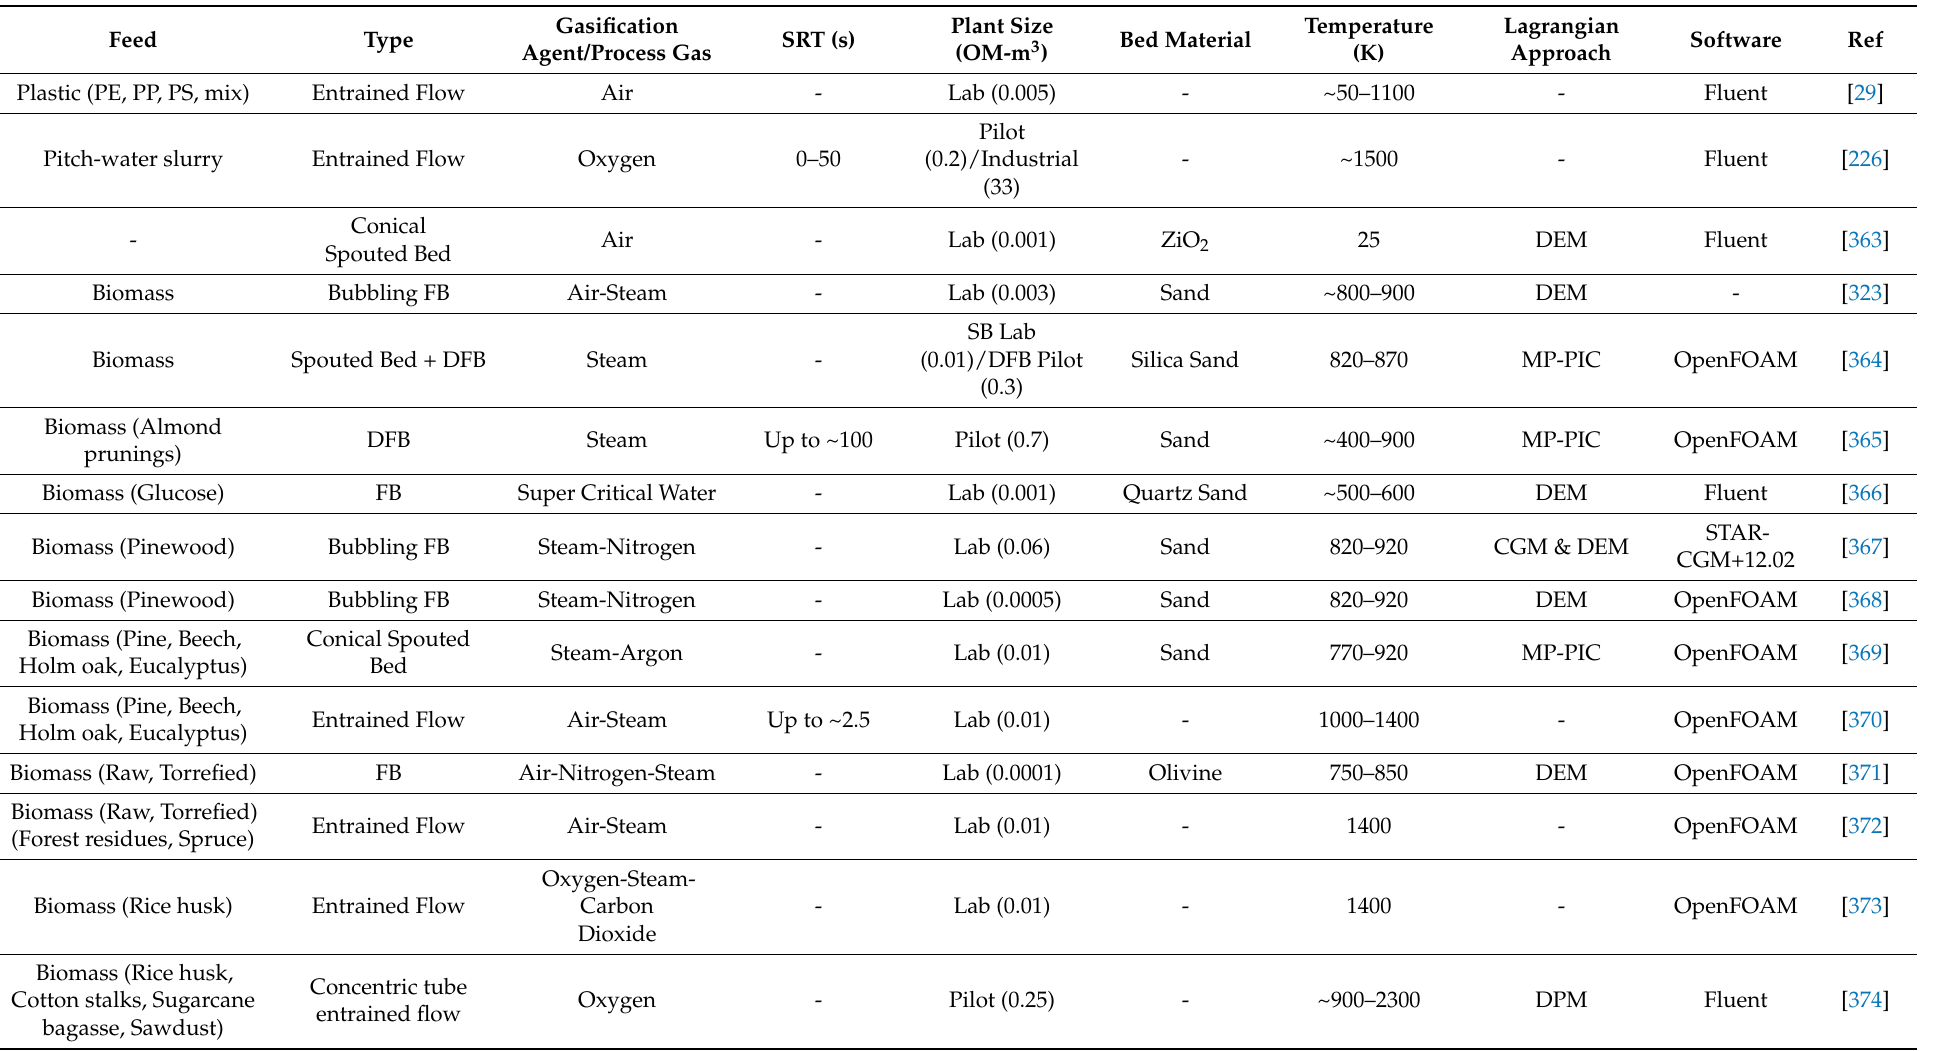
Table 7. Overview of Eulerian-Lagrangian simulation studies for different feedstocks and reactor designs that can be used as a guide in the PWG